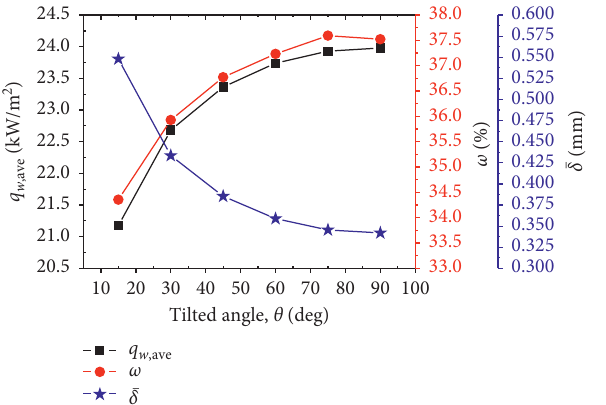
Figure 6: Influence of the tilted angle on heat and mass transfer of the water film evaporation process.